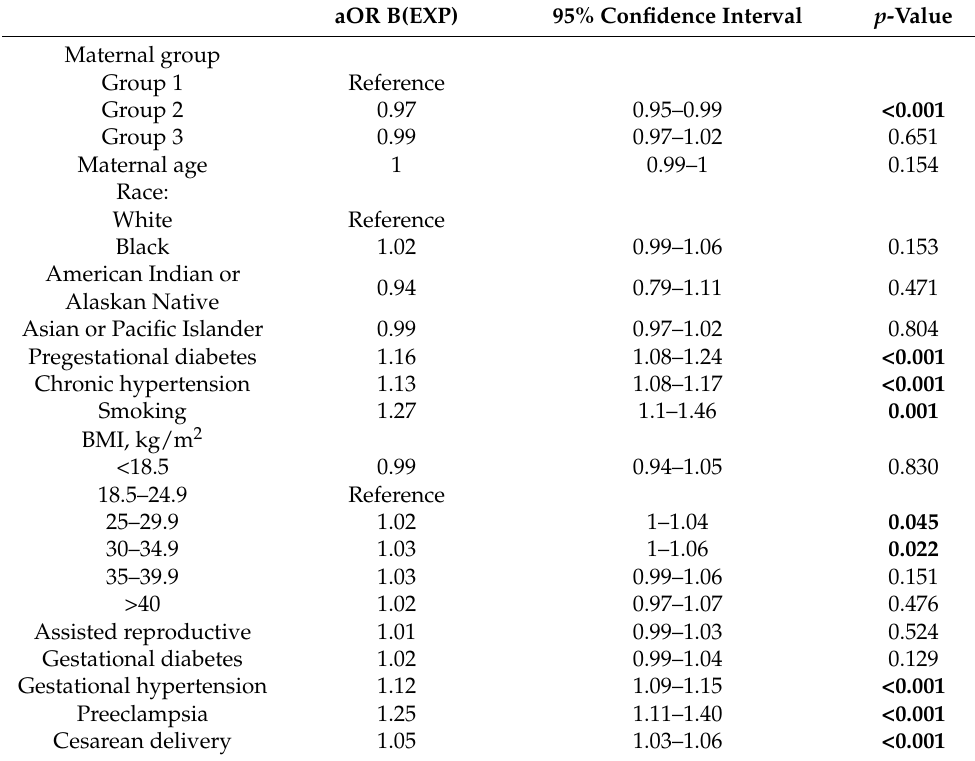
Table 3. Adverse composite neonatal outcome evaluated by multivariable analysis to adjust for